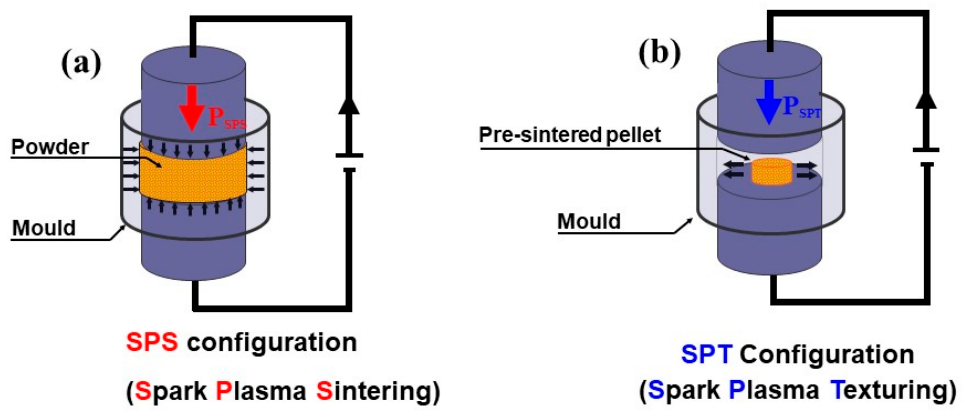
Figure 1. ( a ) Conventional Spark Plasma Sintering (SPS) configuration and the ( b ) new Spark Plasma Texturing [24].